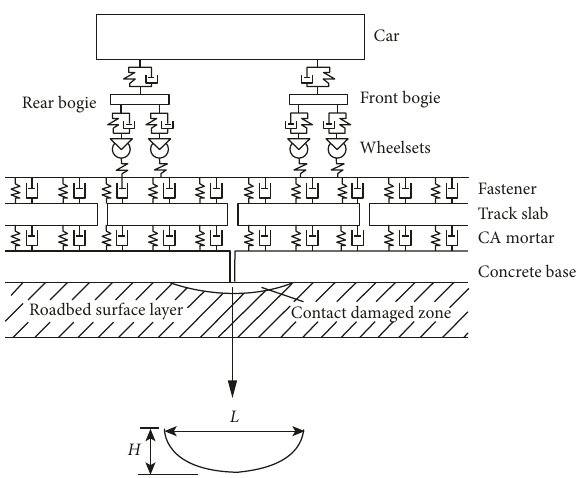
Figure 4: Elliptical-shaped form of contact damaged zone.